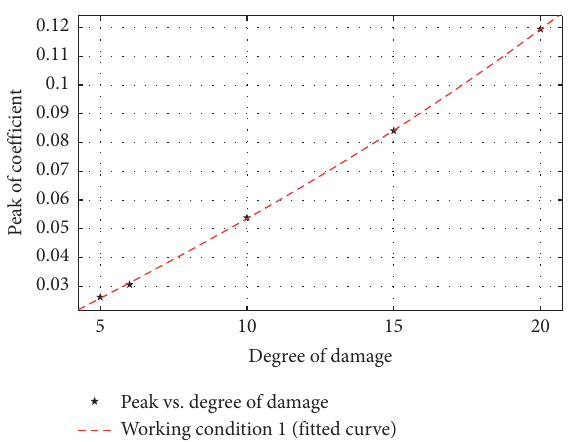
Figure 15: Fitting curve for structure with single damage.